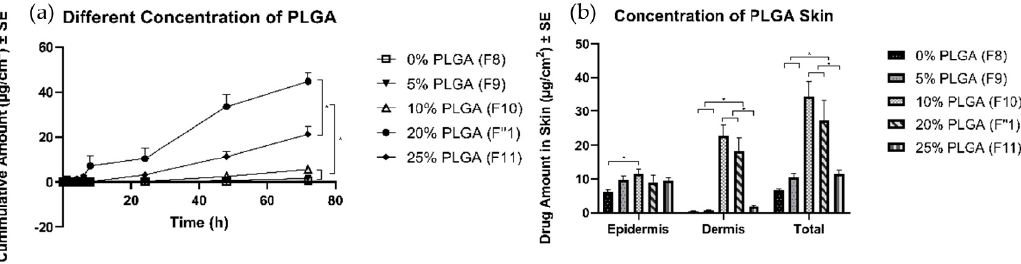
Figure 5. Permeation profiles of TS through porcine ear skin for di ff erent concentrations of PLGA. The group is representative of di ff erent concentrations of PLGA: ( a ) Cumulative amount ( b ) Average amount in the epidermis, dermis, and total